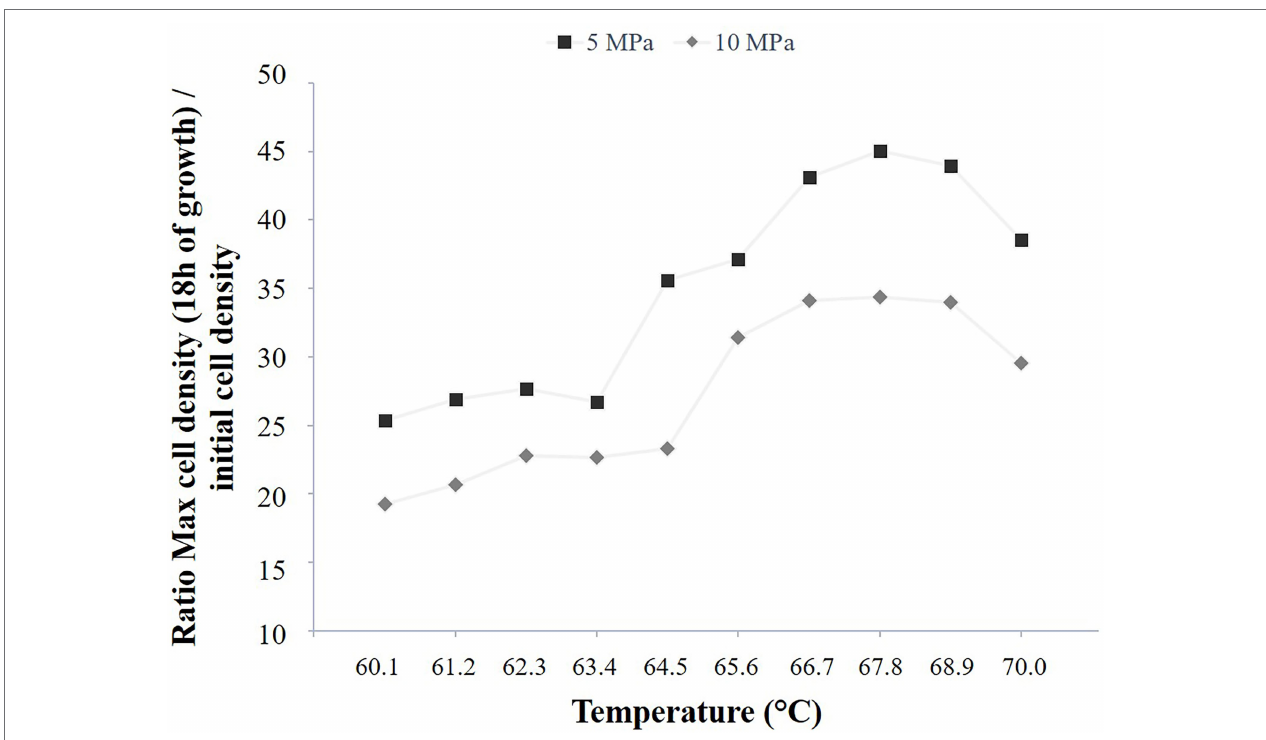
FIGURE 5 | Methanothermococcus thermolithotrophicus growth comparison in a temperature gradient-on-a-chip between two-pressure conditions, 5 and 10 MPa total pressure (2 and 3 MPa of partial pressure of H 2 /CO 2 , respectively). Ratio of the mean cell density after 18 h of growth to the corresponding mean initial cell density, for two temperature gradient microfluidic experiments (temperature: 60.1 ° C–70 °